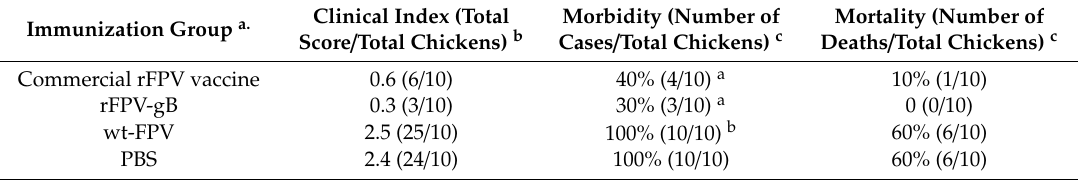
Table 3. The clinical index, morbidity, and mortality of rFPVs after challenge.